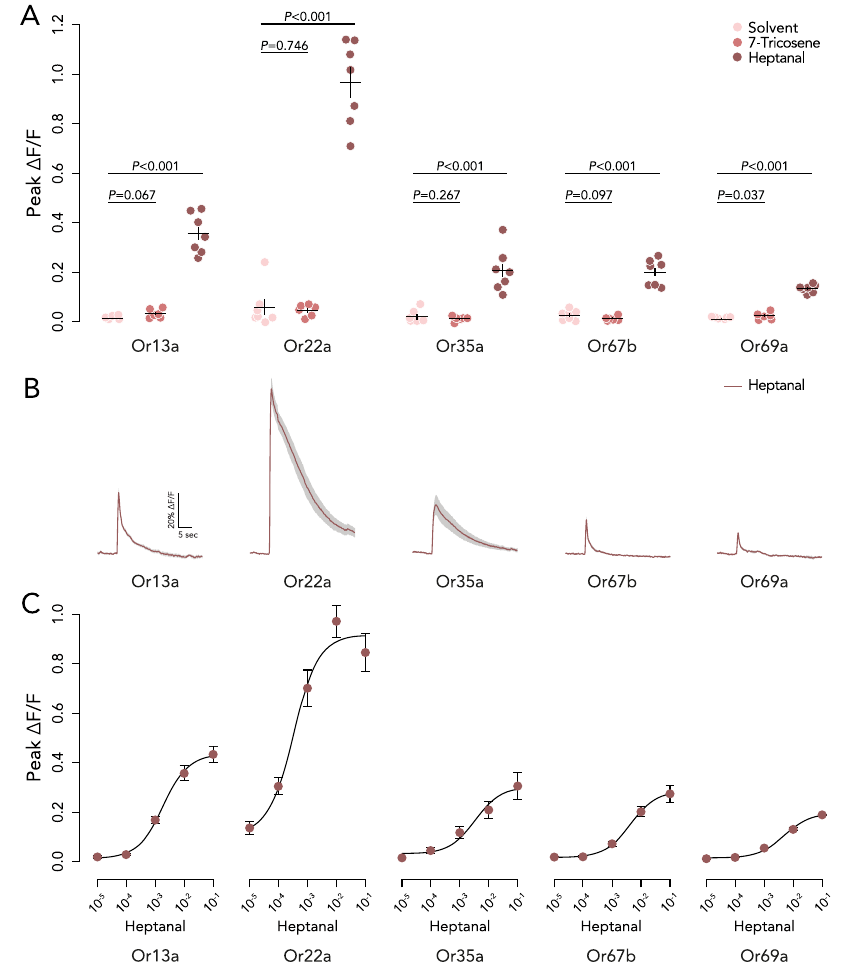
B Calcium fl uorescence traces of the candidate ORNs in responsetoa 10 − 2 dilution ofheptanalvisualizedwithstandarderrorofthemeanasgrayshadedareas. C Dose- response curves of the candidate ORNs to aliquots of heptanal ( n =7 per aliquot). The error bars indicate the standard error of the mean. See Fig. S2 for negative control on Or47b. Source data are provided with this